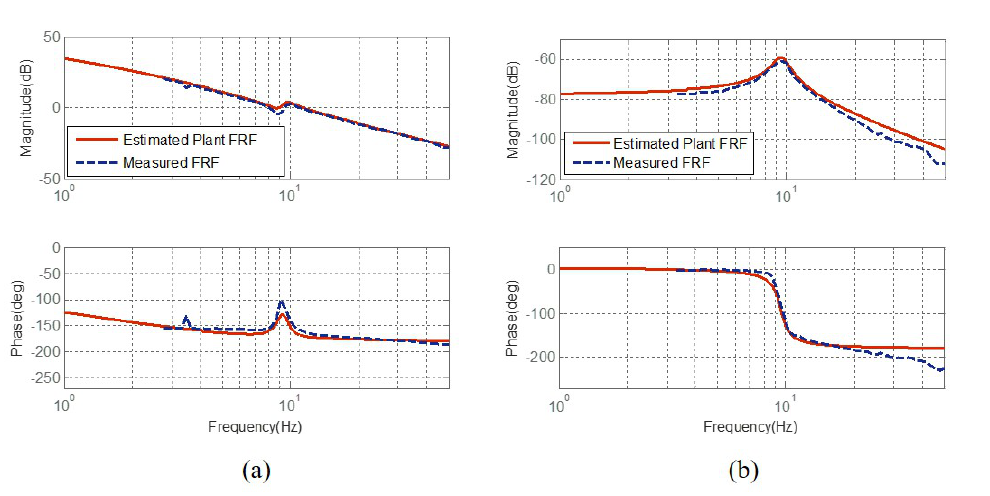
Figure 16. Frequency Response Functions of RFSEA [24]. ( a ) FRFs from motor torque to motor position and ( b ) FRFs from motor torque to spring